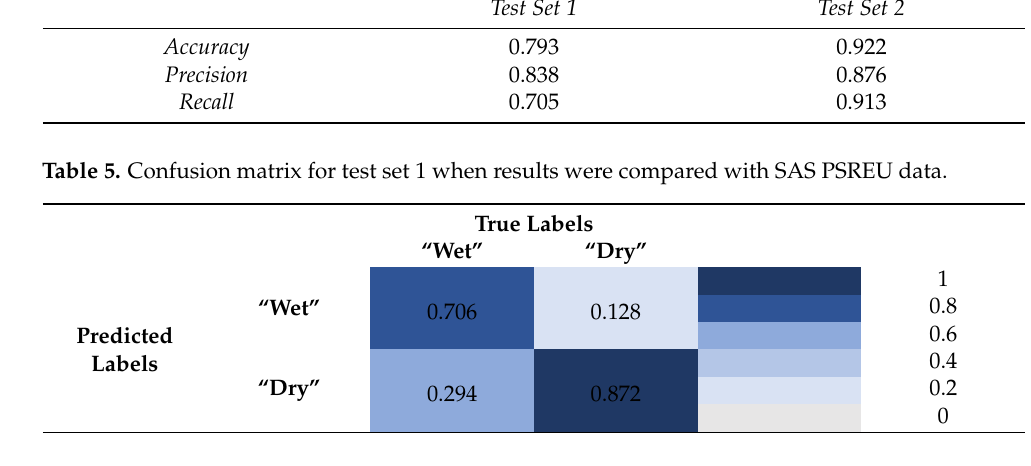
Table 6. Confusion matrix for test set 2 when results were compared with SAS GCREC